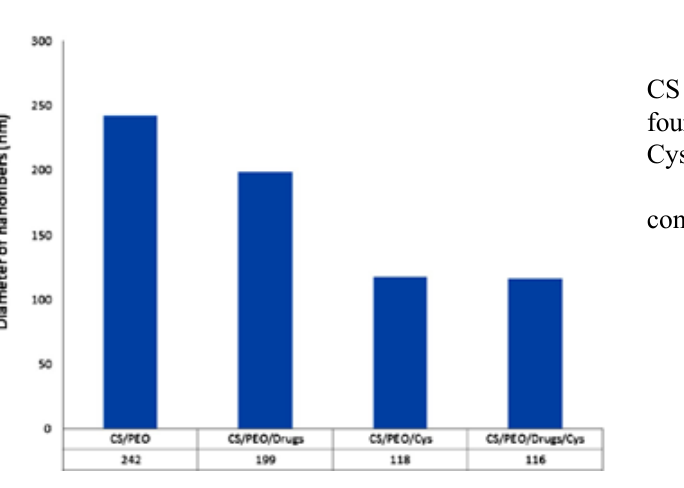
FIGURE 2 - Comparison the diameter of the fibers.